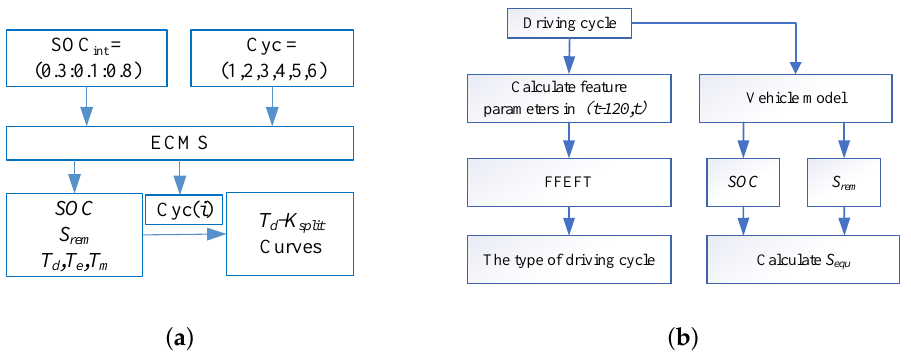
Figure 9. Offline optimization flow diagram for ( a ) and real-time recognition flow diagram for ( b ).